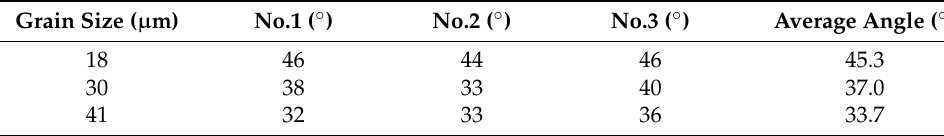
Table 3. The springback angles of the specimens.